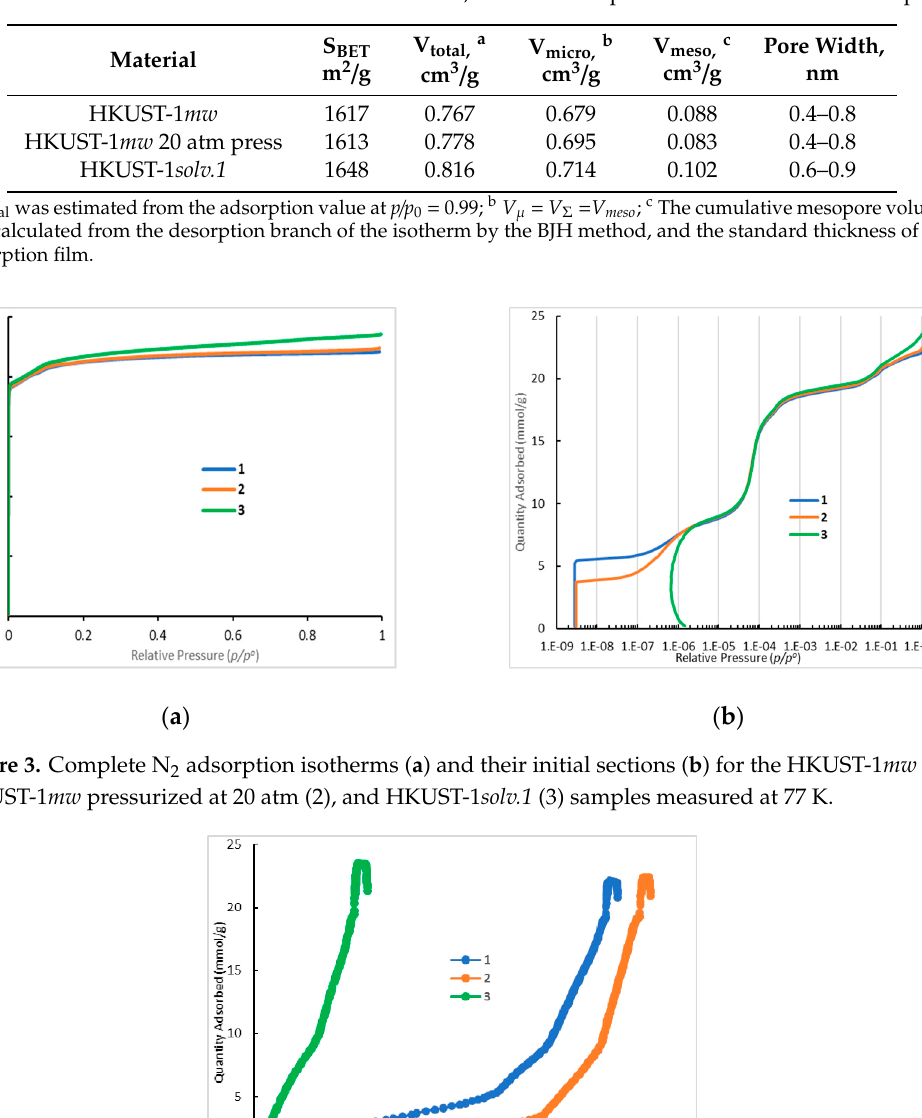
Table 2. Textural characteristics of the HKUST-1 mw , HKUST-1 mw press and HKUST-1 solv.1 samples.